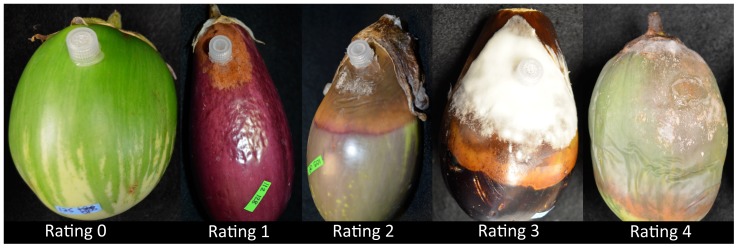
Eggplant Phytophthora fruit rot disease rating scale shown on various eggplant genotypes: 0 =  no visible symptoms, a rating of 1 = <25% symptomatic area, 25%>2<50%, 50%>3<75%, and a rating of 4≥75% symptomatic area of the fruit.